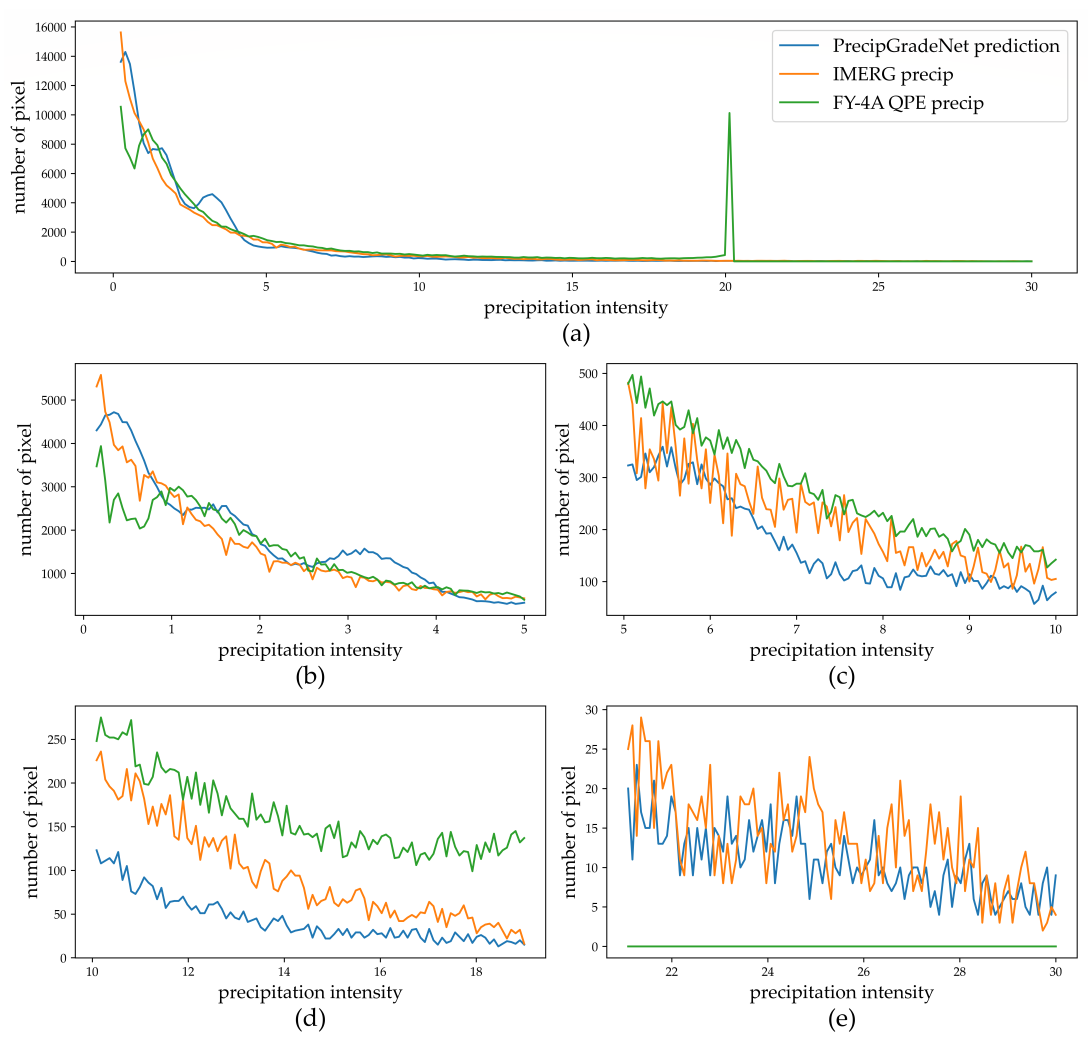
Figure 8 reflects the intensity frequency distribution of PrecipGradeNet retrieval precipitation, FY-4A QPE product precipitation, and IMERG precipitation in different intensity intervals. Figure 8a has a total of 200 binaries, and Figure 8b–e have 100 binaries each. Figure 8a shows that there is a spike at 20 mm/h in the FY-4A L2 QPE product, which indicates that there is overflow in the detection of heavy precipitation by the FY-4A L2 QPE. Figure 8a,b shows that there are more missing cases in the discrimination of the light precipitation by FY-4A L2 QPE, while this does not happen in PrecipGradeNet. Figure 8c shows that the number of pixels discerned by PrecipGradeNet and FY-4A L2 QPE in the medium precipitation interval is approximately the same, with some underestimate by PrecipGradeNet and some overestimate by FY-4A L2 QPE. Figure 8d shows that in the lower part of the high precipitation, PrecipGradeNet is a bit underestimated and FY-4A L2 QPE is a bit overestimated. Figure 8e shows that the number of heavy precipitation pixels retrieved by PrecipGradeNet is closer to that of IMERG.